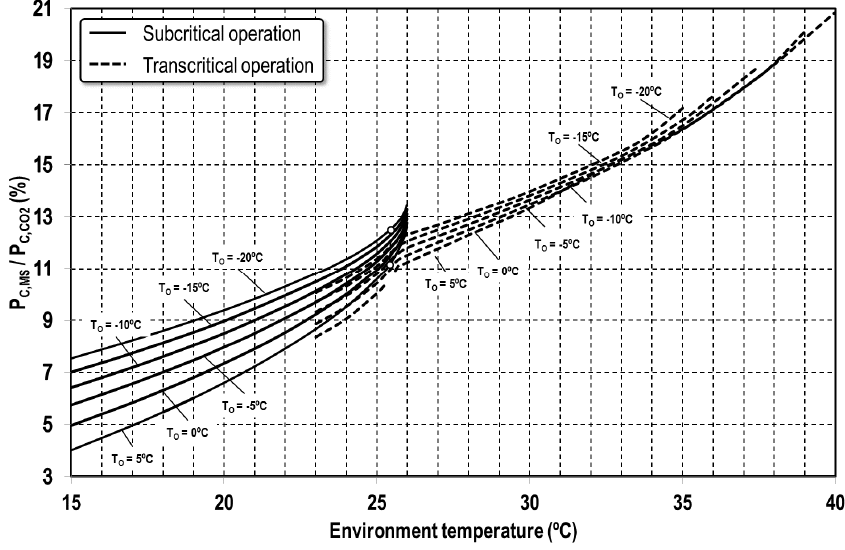
Figure 8. Ratio of compressor’s power consumptions of the MS cycle.